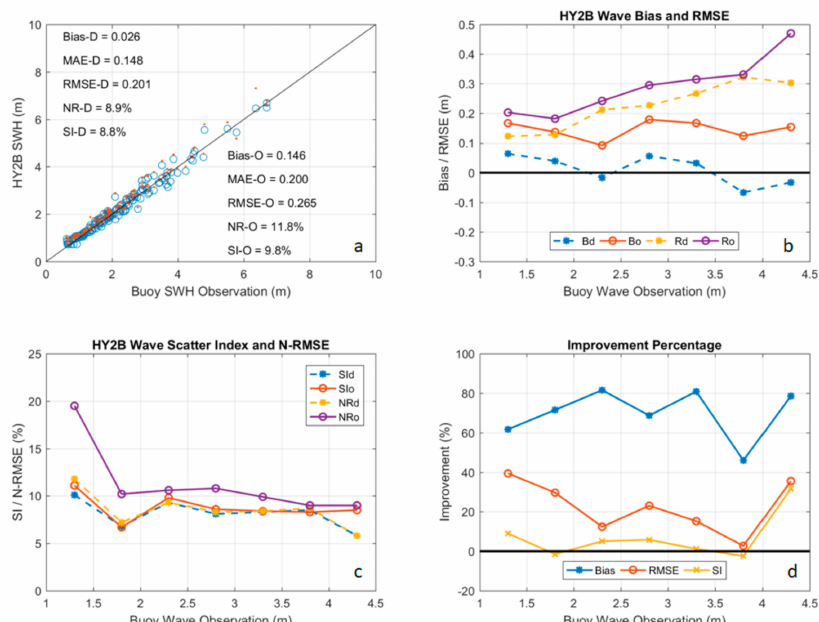
Figure 7. Detailed comparison between the DNN scheme 3 and original HY2B SWH. ( a ) Shows scatter plots of SWH from buoys and HY2B. Red dots and blue circles stand for original HY2B and DNN calibration, respectively; ( b ) shows the bias and RMSE variation with SWH, Bd, and Bo indicate the bias of DNN calibration and original HY2B, respectively, Rd and Ro represent the RMSE of DNN and original. While ( c ) shows the SI and NRMSE variation with SWH, SId and SIo stand for SI of DNN and original; NRd and NRo stand for NRMSE of DNN and original; ( d ) shows the percentage of improvement by the DNN calibration for bias, RMSE, and SI.